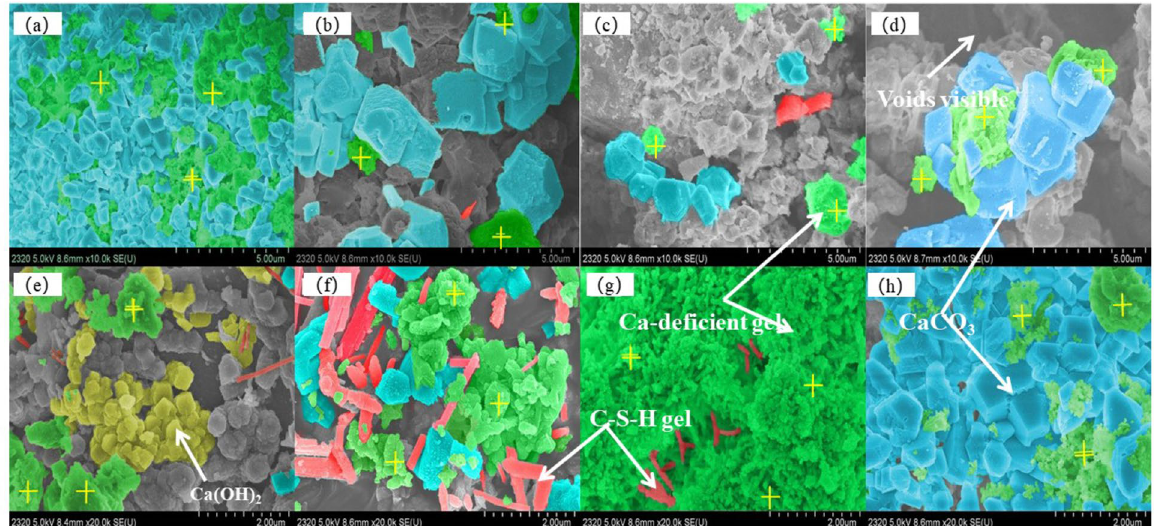
Figure 4. SEM images of LFS materials following hydration and carbonation under varying conditions: reaction temperatures of: ( a ) 20 ℃ , ( b ) 40 ℃ , ( c ) 60 ℃ , ( d ) 80 ℃ ; LFS particle sizes of: ( e ) < 38 μm, ( f ) 38–48 μm,